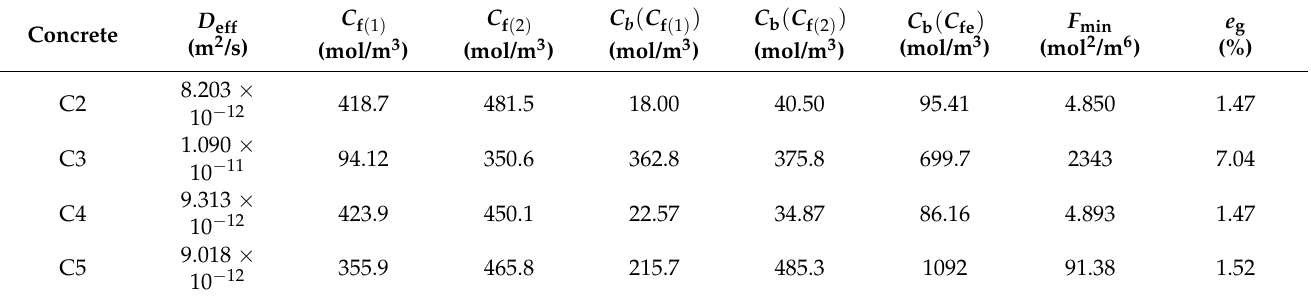
Table 6. The effective chloride diffusion coefficients ( D eff ) and the vertices coordinates of binding